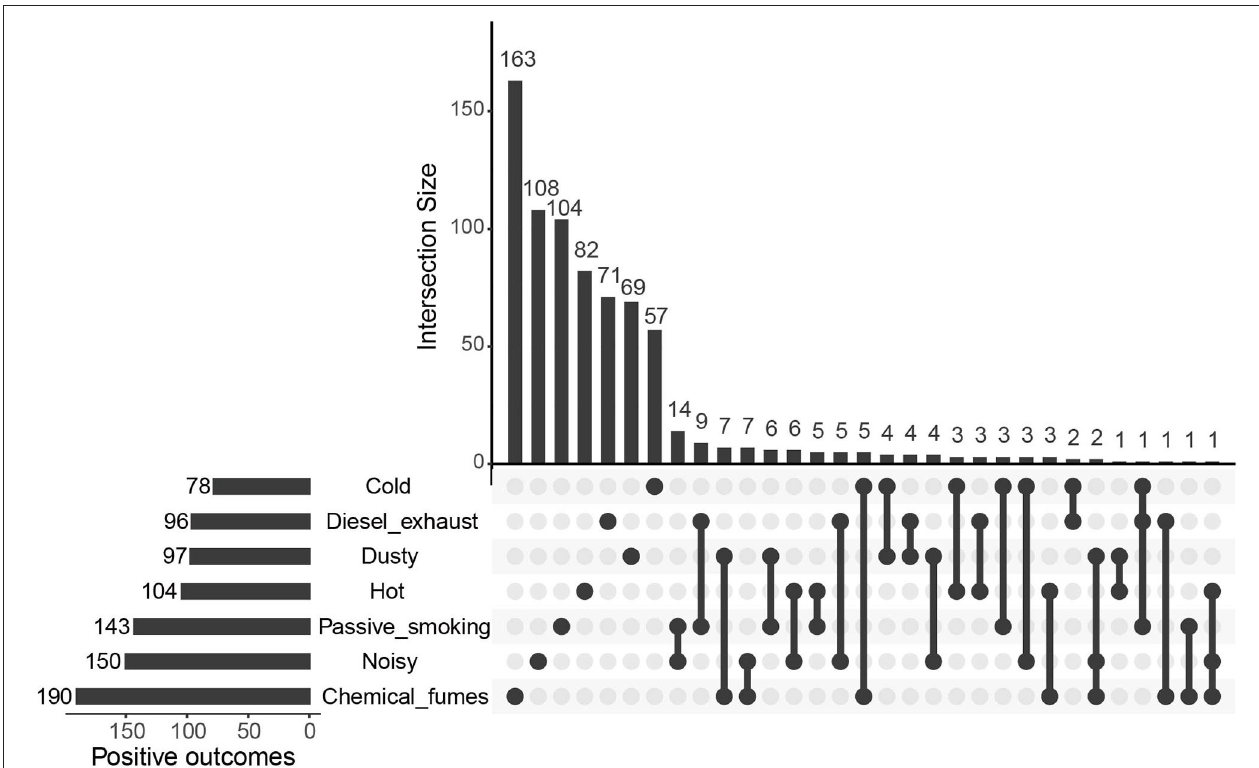
FIGURE 2 | Preliminary screening of plasma proteins possibly affected by workplace environments. Mendelian randomization (MR) results with p < 0.05 were counted, with the Upset Plot showing outcomes overlapping among exposures to different